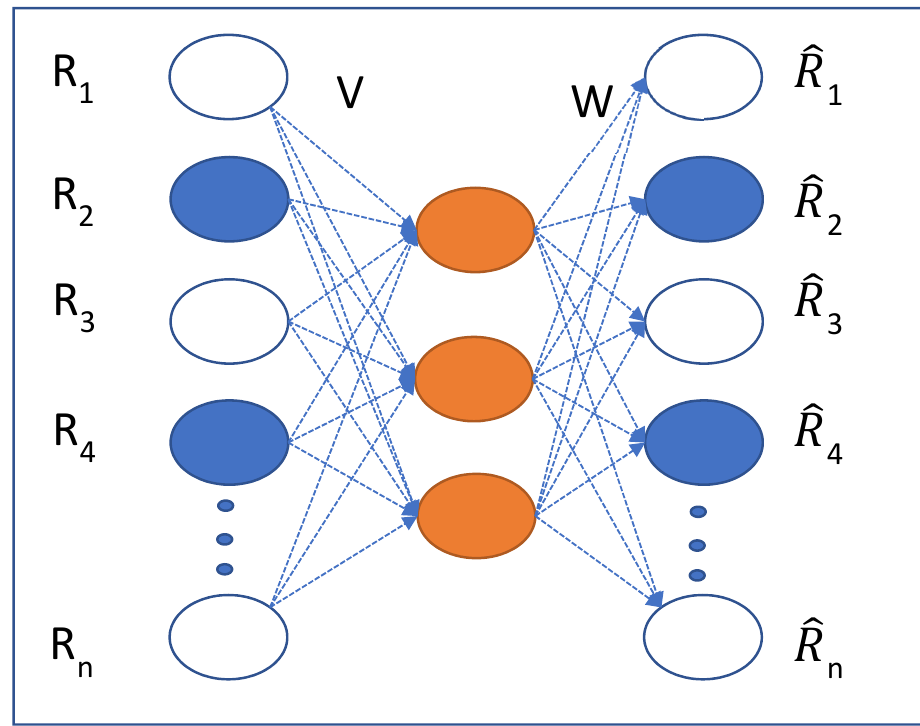
Figure 1. Structure of an autoencoder.